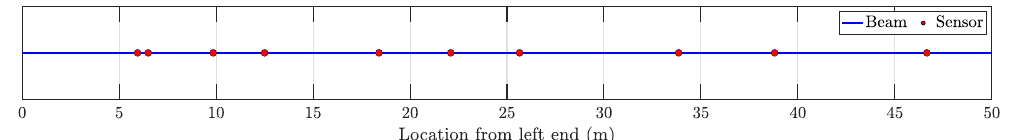
Figure 2. Simulation on the simply supported